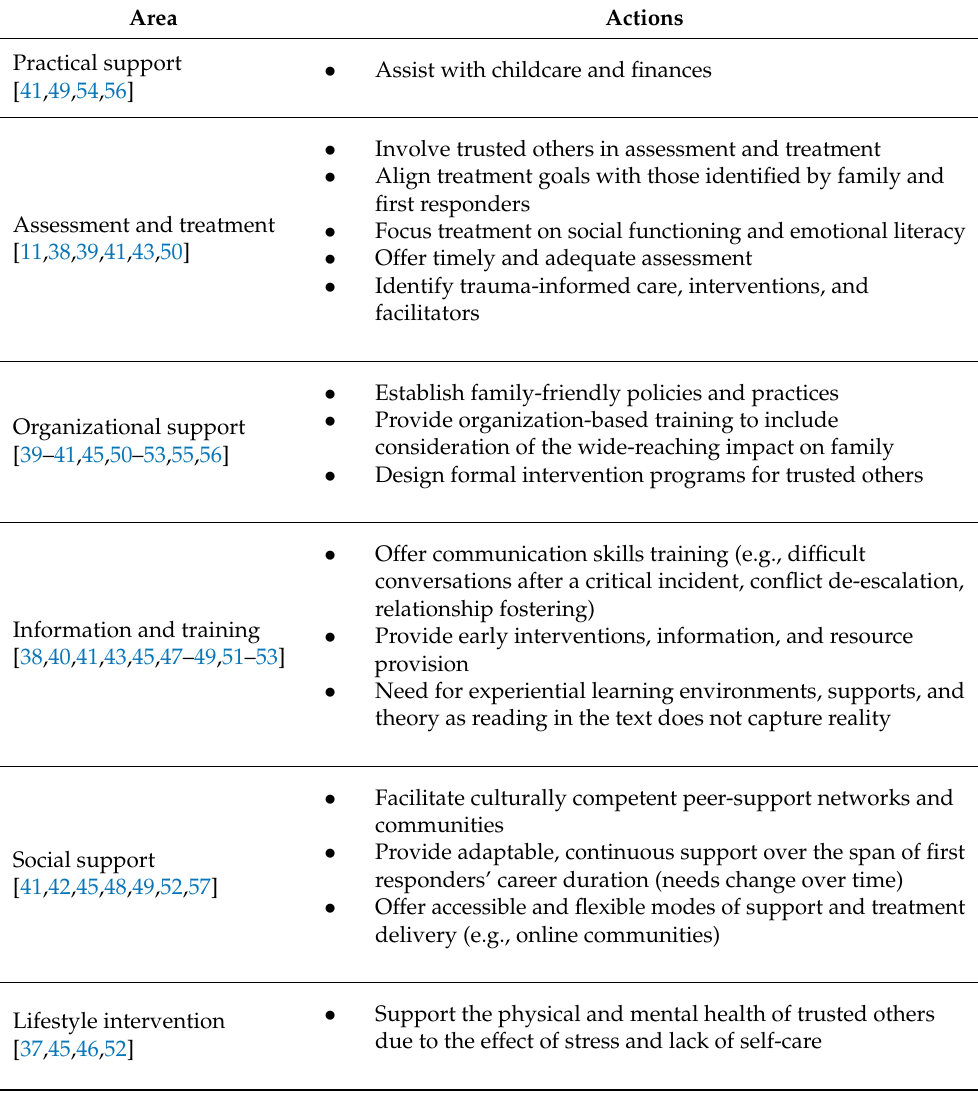
Table 5. Support